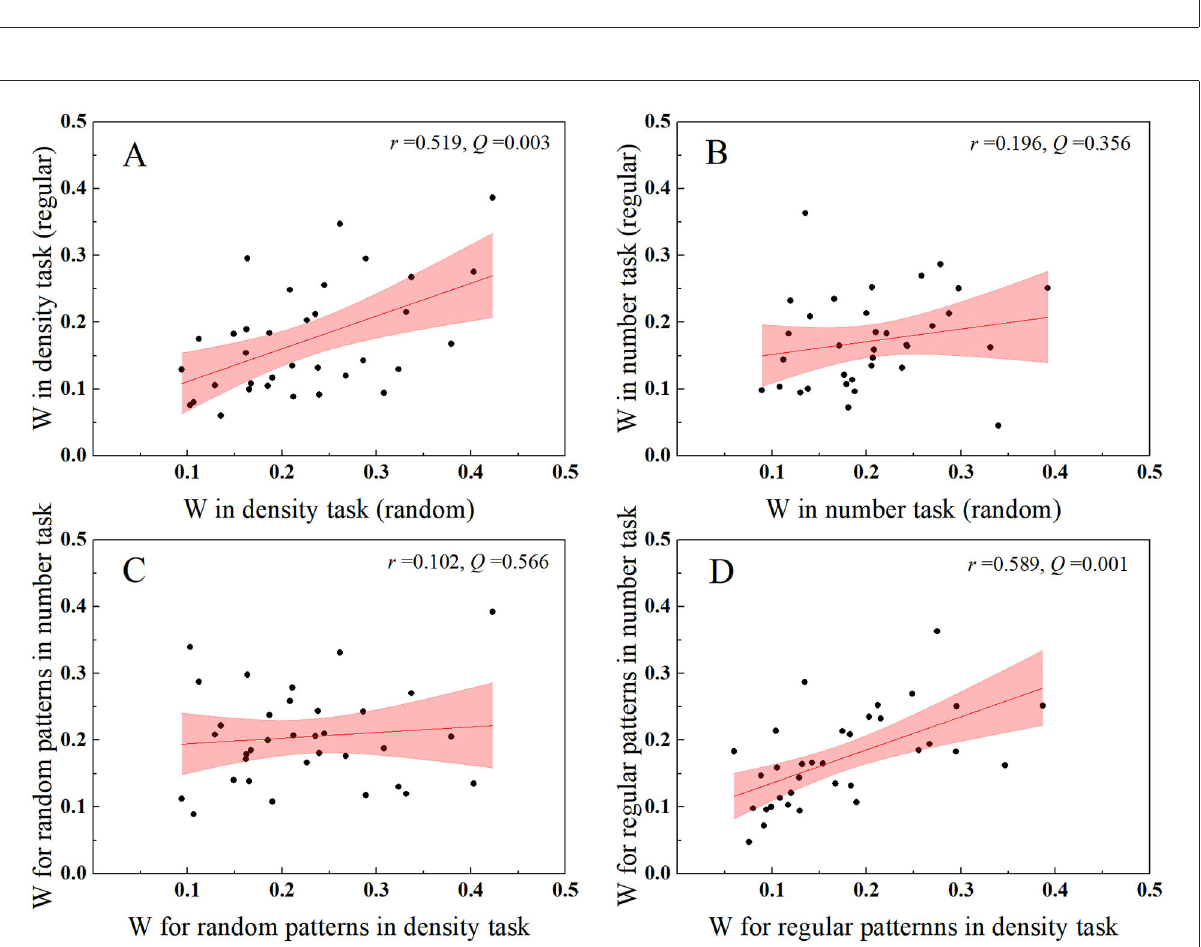
FIGURE6 Scatters for individual Weber fractions between conditions either with the same task instruction or with the same distribution. (A,B) A significant correlation was found between patterns in the density task, whereas no correlation was found between patterns in the number task. (C,D) No significant correlation was found for Weber fractions of random patterns between tasks, whereas a significant correlation was found for Weber fractions of regular patterns between tasks. The pink area donates 95%